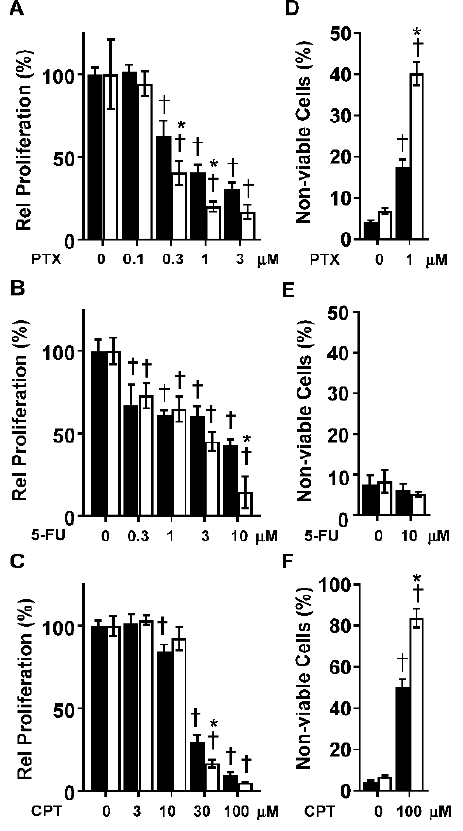
Figure 4. Suppression of CYP1B1 sensitizes MDA-MB-231 cells to the effects of paclitaxel (PTX), 5-fluorouracil (5-FU), and cisplatin (CPT). ( A ) CV (black bars) and CYP1B1 KD (white bars) cells were treated with increasing concentrations of PTX (72 h) before cell proliferation was determined. Values are the mean ± SD, n = 5. ( B ) CV and CYP1B1 KD cells were treated with increasing concentrations of 5-FU (72 h) before cell proliferation was determined. Values are presented as the mean ± SD, n = 5. ( C ) CV and CYP1B1 KD cells were treated with increasing concentrations of CPT (72 h) before cell proliferation was determined. Values are presented as the mean ± SD, n = 6. For ( A – C ), relative proliferation was calculated by setting the vehicle control for each cell line to 100%. The * indicates a significant difference ( p ≤ 0.05) in comparison to CV within the same concentration of drug and the † indicates a significant difference from vehicle within the same cell line by two-way ANOVA followed by Tukey’s multiple comparisons. ( D ) CV and CYP1B1 KD cells were treated with vehicle or PTX (1 μM, 72 h) followed by measurement of dead cells. Values are the mean ± SD, n = 5. ( E ) CV and CYP1B1 KD cells were treated with control vehicle or 5-FU (10 μM, 72 h) followed by measurement of dead cells. Values are the mean ± SD, n = 3. ( F ) CV and CYP1B1 KD cell were treated with control vehicle or CPT (100 μM, 72 h) followed by measurement of dead cells. Values are the mean ± SD, n = 5–9. The * indicates a significant difference ( p ≤ 0.05) in comparison to CV within the same concentration of drug and the † indicates a significant difference from vehicle within the same cell line using two-way ANOVA followed by Tukey’s multiple comparisons.